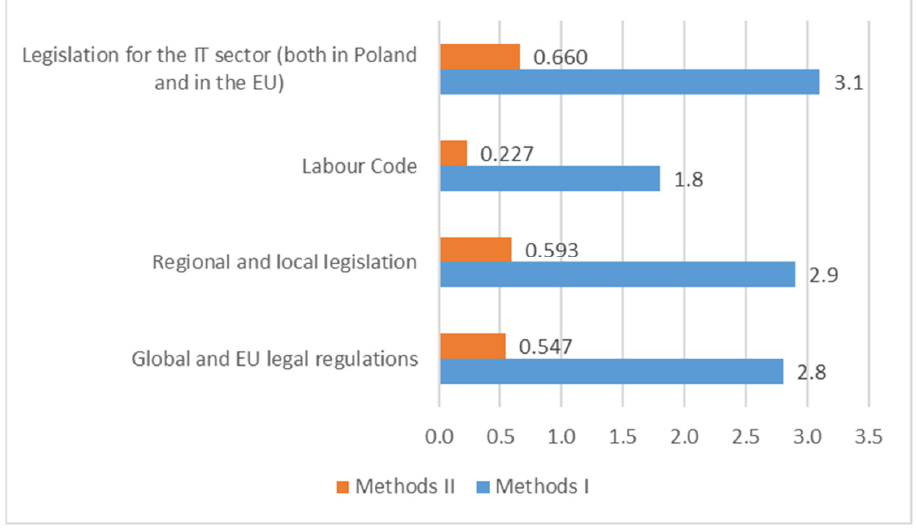
Figure 12. Summary of the results for legislative factors with both methods. Authors’ own study.